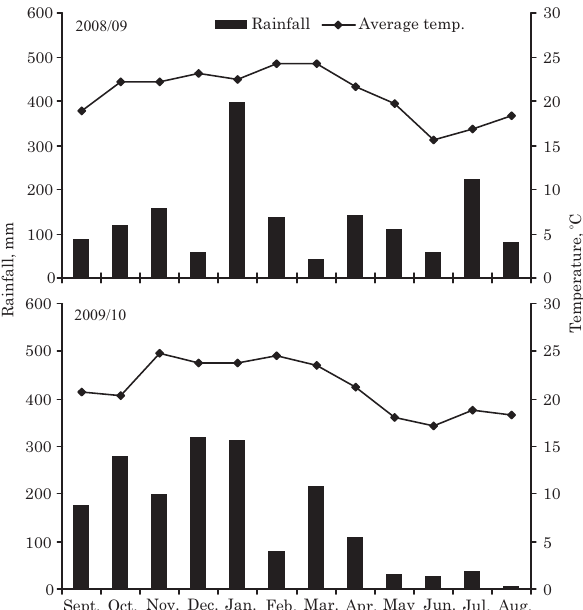
Figure 1. Monthly rainfall and average temperature in the experimental area, from September 2008 to August